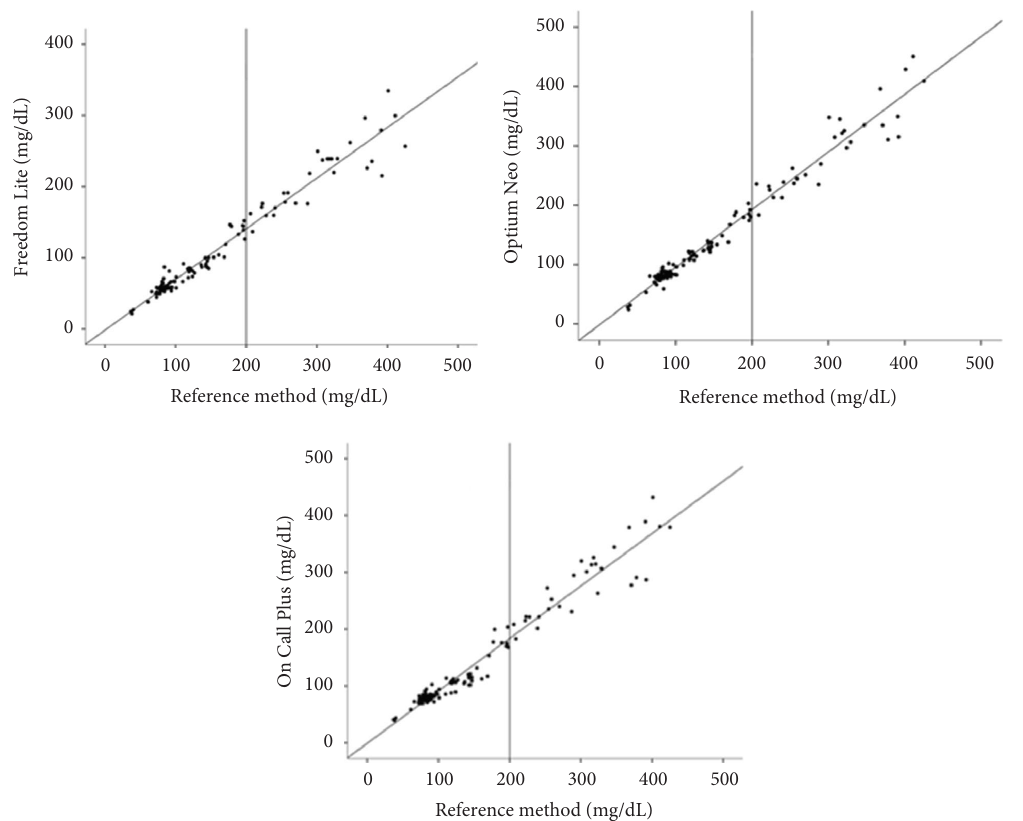
Figure 2: Graphics of glycemia dispersion obtained by the reference method ( x ) and the Freedom Lite, FreeStyle Optium Neo ® , and On Call Plus glucometers ( y ) in dogs. Table 3: Bland–Altman analysis of the three evaluated glucometers with the reference method in dogs.